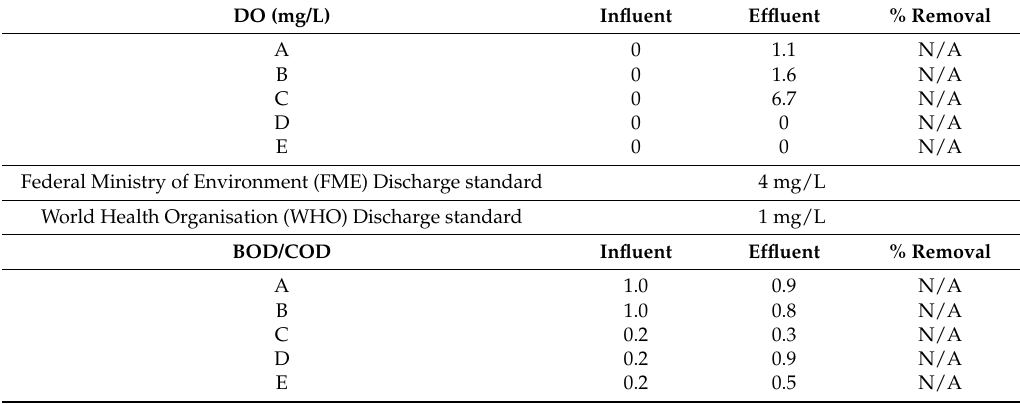
Table 1. Dissolved Oxygen (DO) concentration and Biochemical Oxygen Demand- Chemical Oxygen Demand Ratio (BOD/COD) of paint effluents in the study area. DO